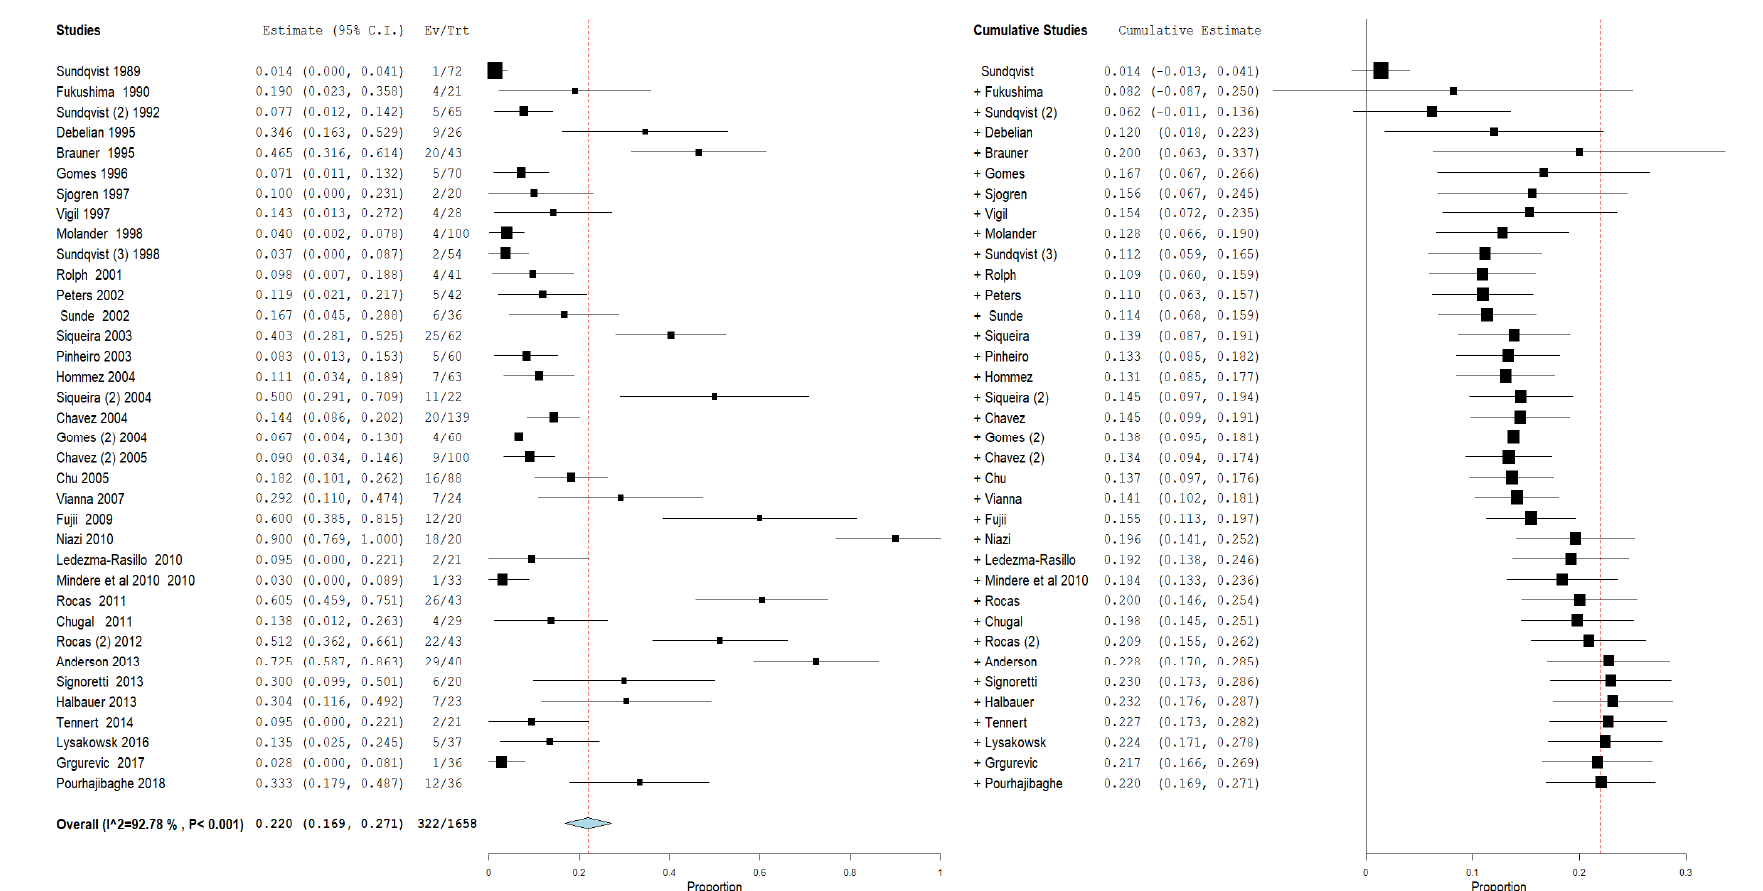
Figure 3. Forest plot of the random effects model of the meta-analysis cumulative of the primary outcome.